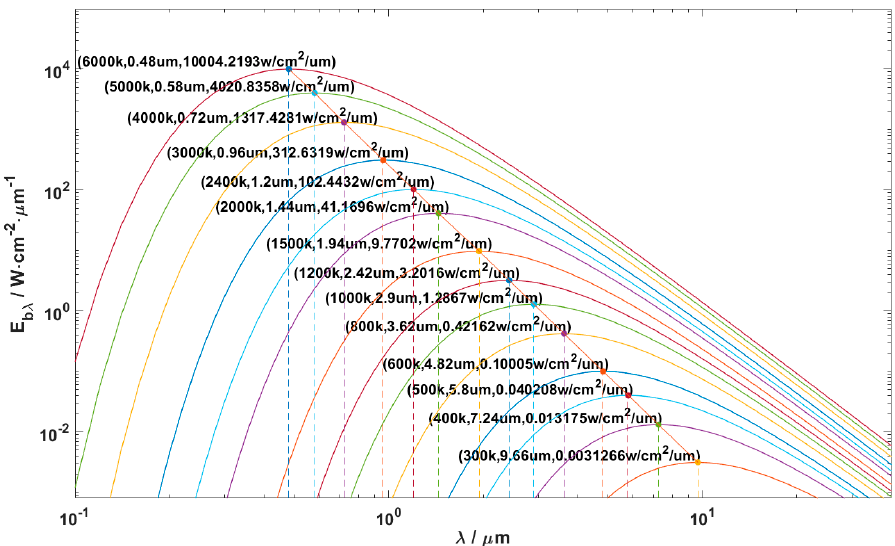
Figure 3. The variation rule of the blackbody spectral radiant emissivity with wavelengths at different temperatures.